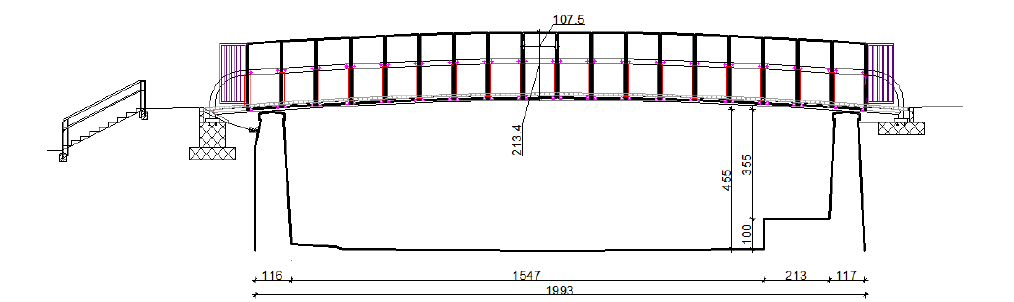
Figure 2. Bridge plan.